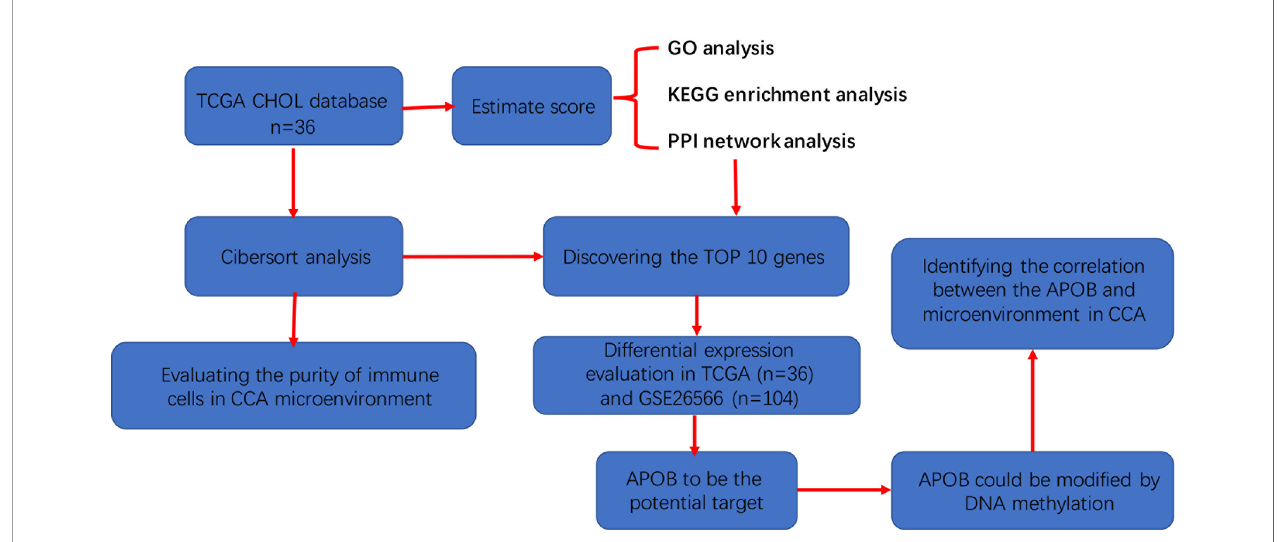
FIGURE 8 | The detailed fl owchart of this study to discover the role of APOB in the microenvironment of